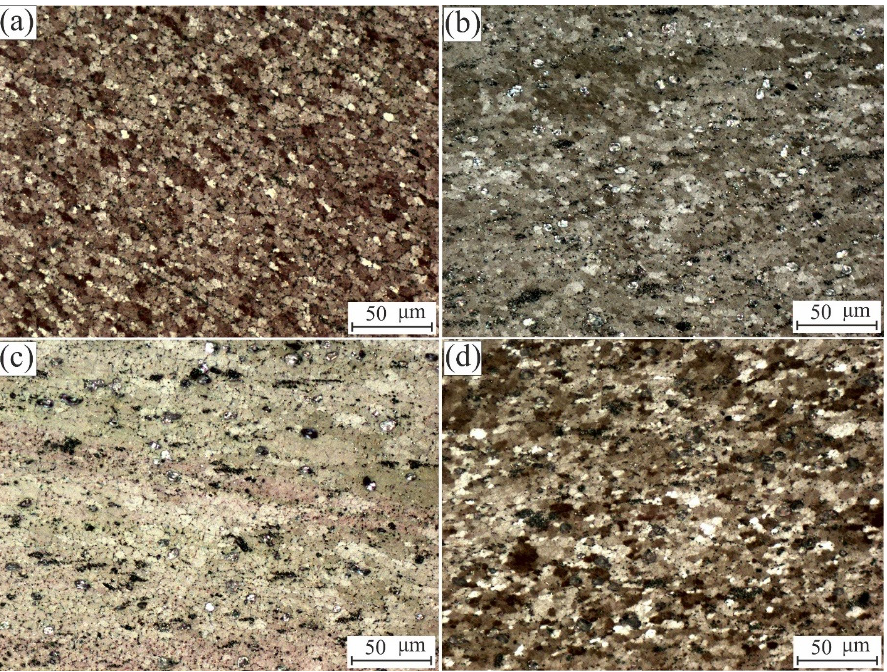
Table 5. The average grain size of the as-received alloy, after FSP, and manufactured surface nanocomposites. – Figure 5. The microstructure of the stirred zone of the manufactured surface nanocomposites: ( a ) Al